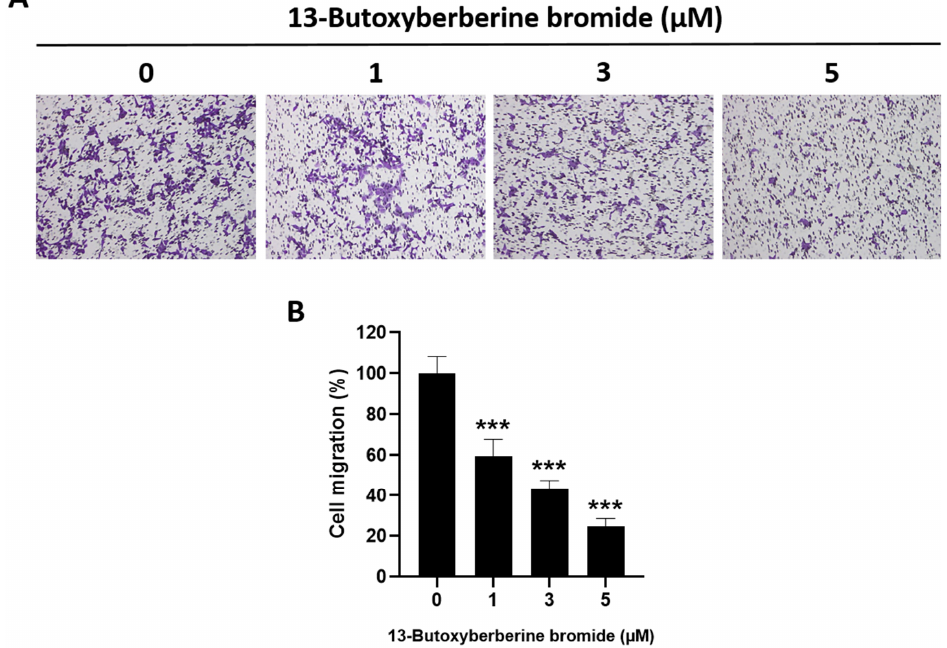
Figure 3. Inhibitory effect of 13-butoxyberberine bromide on cell migration in A431 cells. ( A ) Morphology of migrated A431 cells after staining with crystal violet under an inverted microscope (100× magnification). ( B ) The histogram shows percentage of cell migration after incubation with 13-butoxyberberine bromide. Data were expressed as mean ± SD ( n = 3). *** p < 0.001; significant difference from the control group.